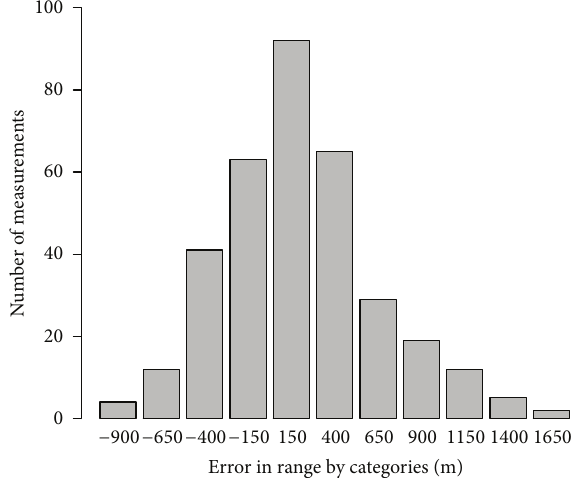
Figure 7: Distribution of Δ𝐷 after